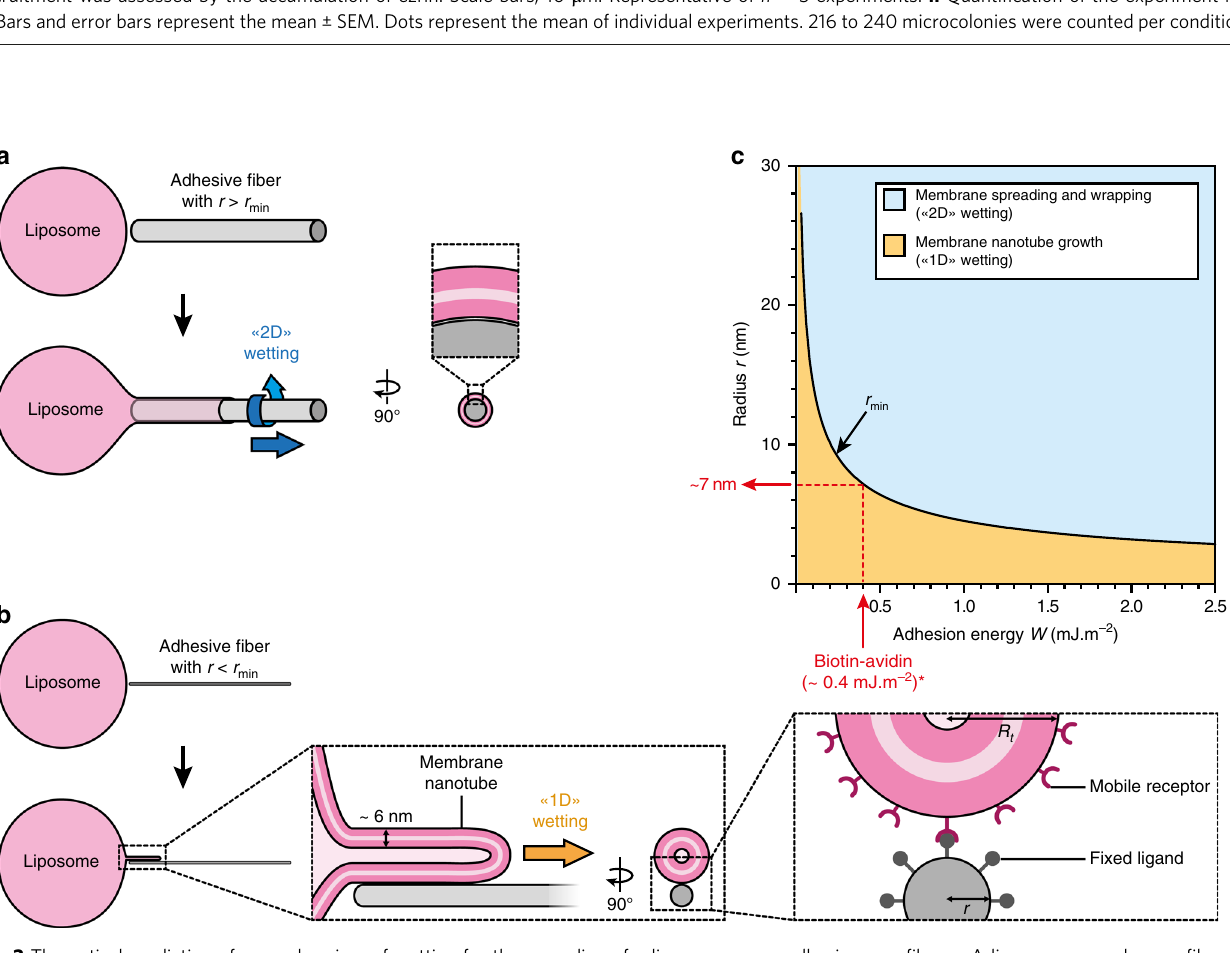
Fig. 2 The morphology of plasma membrane protrusions is dictated by the fi ber-like morphology of T4P. a Scanning electron micrograph of an endothelial cell after 10 min infection and stabilization of the T4P with a monoclonal antibody. Colorized crop shows plasma membrane protrusions (magenta, dotted lined) attached alongside T4P fi bers (yellow). Scale bars, 1 μ m and 200 nm. n = 2 independent experiments performed in duplicate. b Same experiment after immunogold labeling of T4P. Protr., protrusions. Scale bars, 500 nm and 200 nm. n = 2 independent experiments performed in duplicate. c Transmission electron micrograph of a microcolony of Nm after high pressure freezing and freeze substitution, showing plasma membrane protrusions